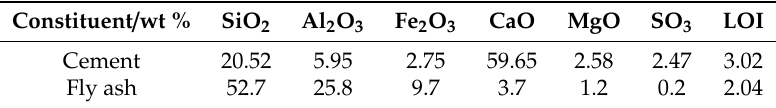
Table 1. Chemical composition of cement and fly